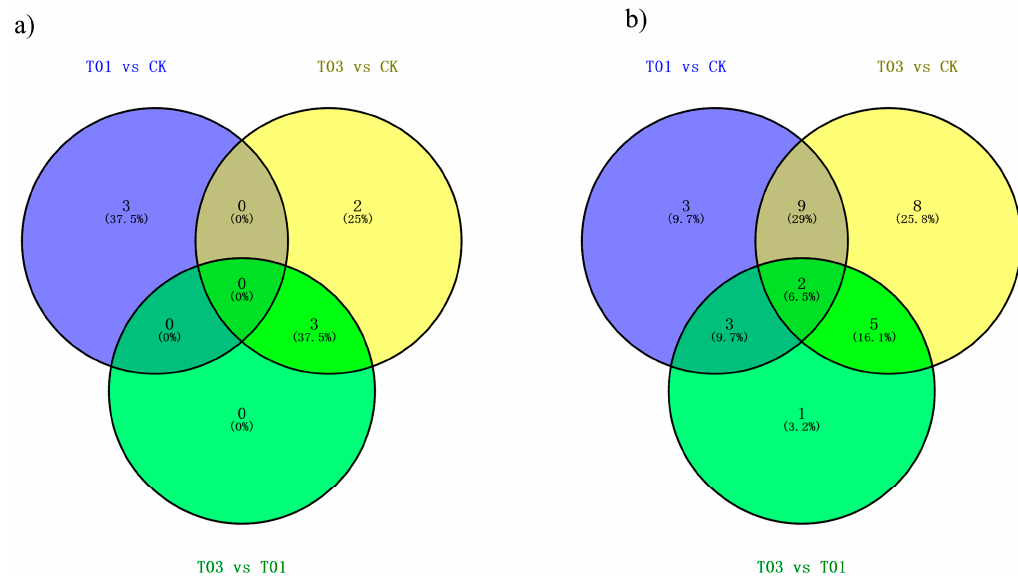
Figure 7. Annotation of predicted target genes for miRNAs. ( a ) Number of target genes in various databases; ( b ) Histogram of gene ontology (GO) classification of predicted target genes. The left and right y-axis indicates the percentage and number of a specific category of genes in that main category, respectively.